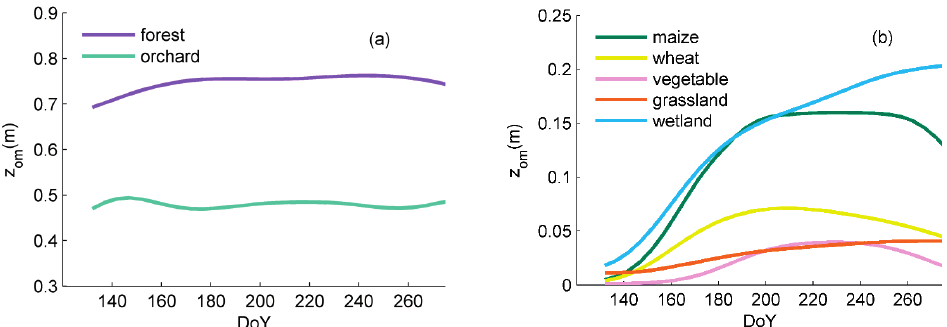
Figure 5. Time series of the regionally averaged aerodynamic roughness length during the growing season for different vegetation type: ( a ) forest vegetation; ( b ) non-forest